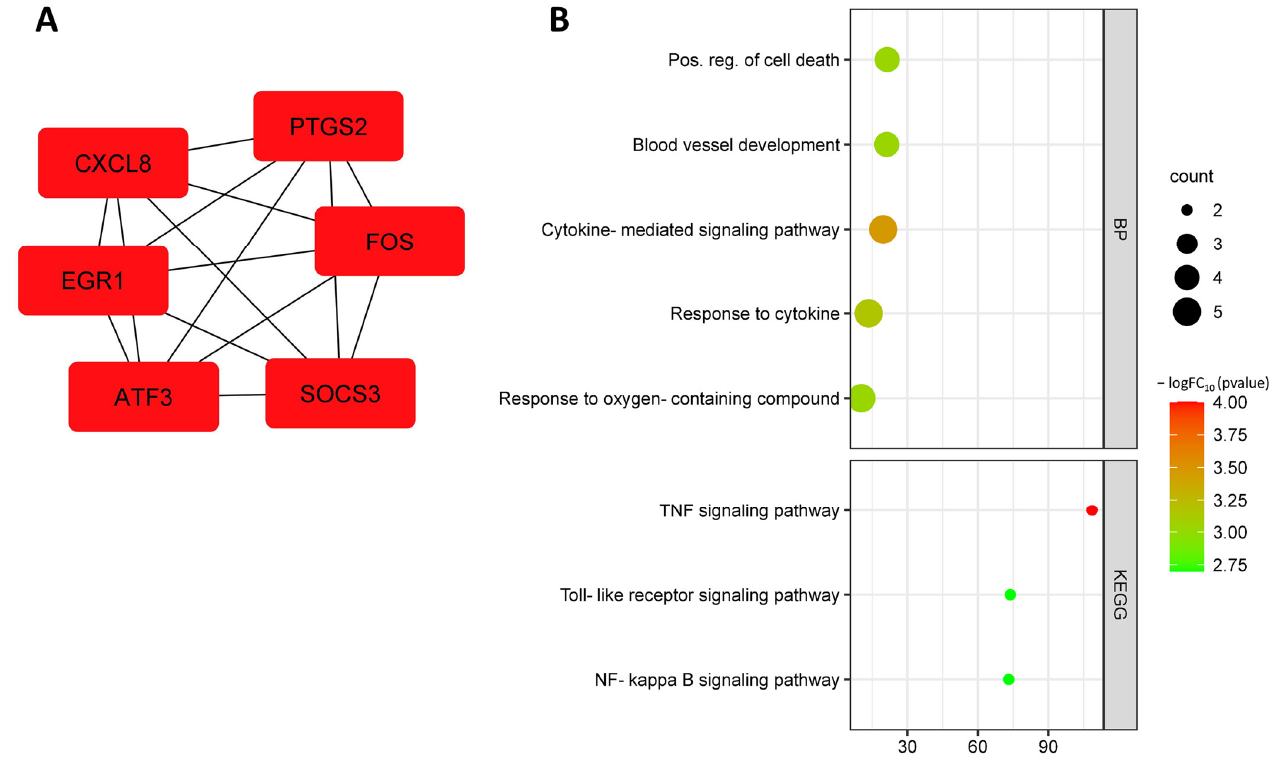
Figure 7. Up-regulated hub DEGs from dataset GSE141136 ( A ); functional enrichment of up-regulated hub DEGs from dataset GSE141136 ( B ). Table 3. Functional roles and general information of the up-regulated hub